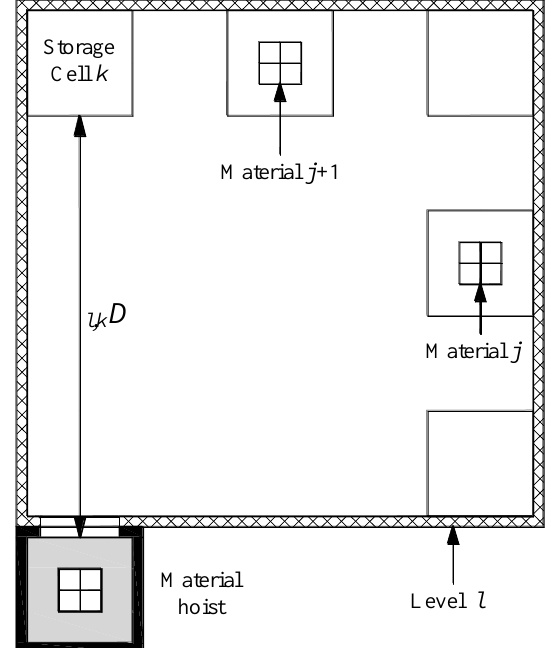
Figure 6. Floor plan at floor l installing material storage cell.